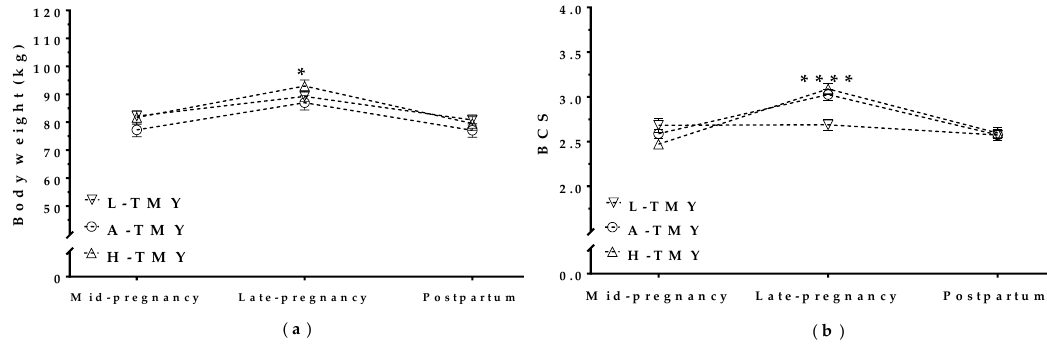
Figure 3. Maternal body weight ( a ) and body condition score ( b ) in mature ewes with high, average, and low total milk yield during concurrent gestation and lactation and in the postpartum period; L-TMY: low-yielding sheep with a TMY (total Milk Yield) <220L/lactation; A-TMY: average yielding sheep (220 – 371 L); H-TMY: high-yielding sheep (>371 L). Data are mean ± standard error of the mean (SEM). Significant interactions between pregnancy/postpartum stage and TMY ( p < 0.05 for BW and p < 0.001 for BCS). Asterisks indicate significant differences between groups at each time point (**** p < 0.0001; * p < 0.05).